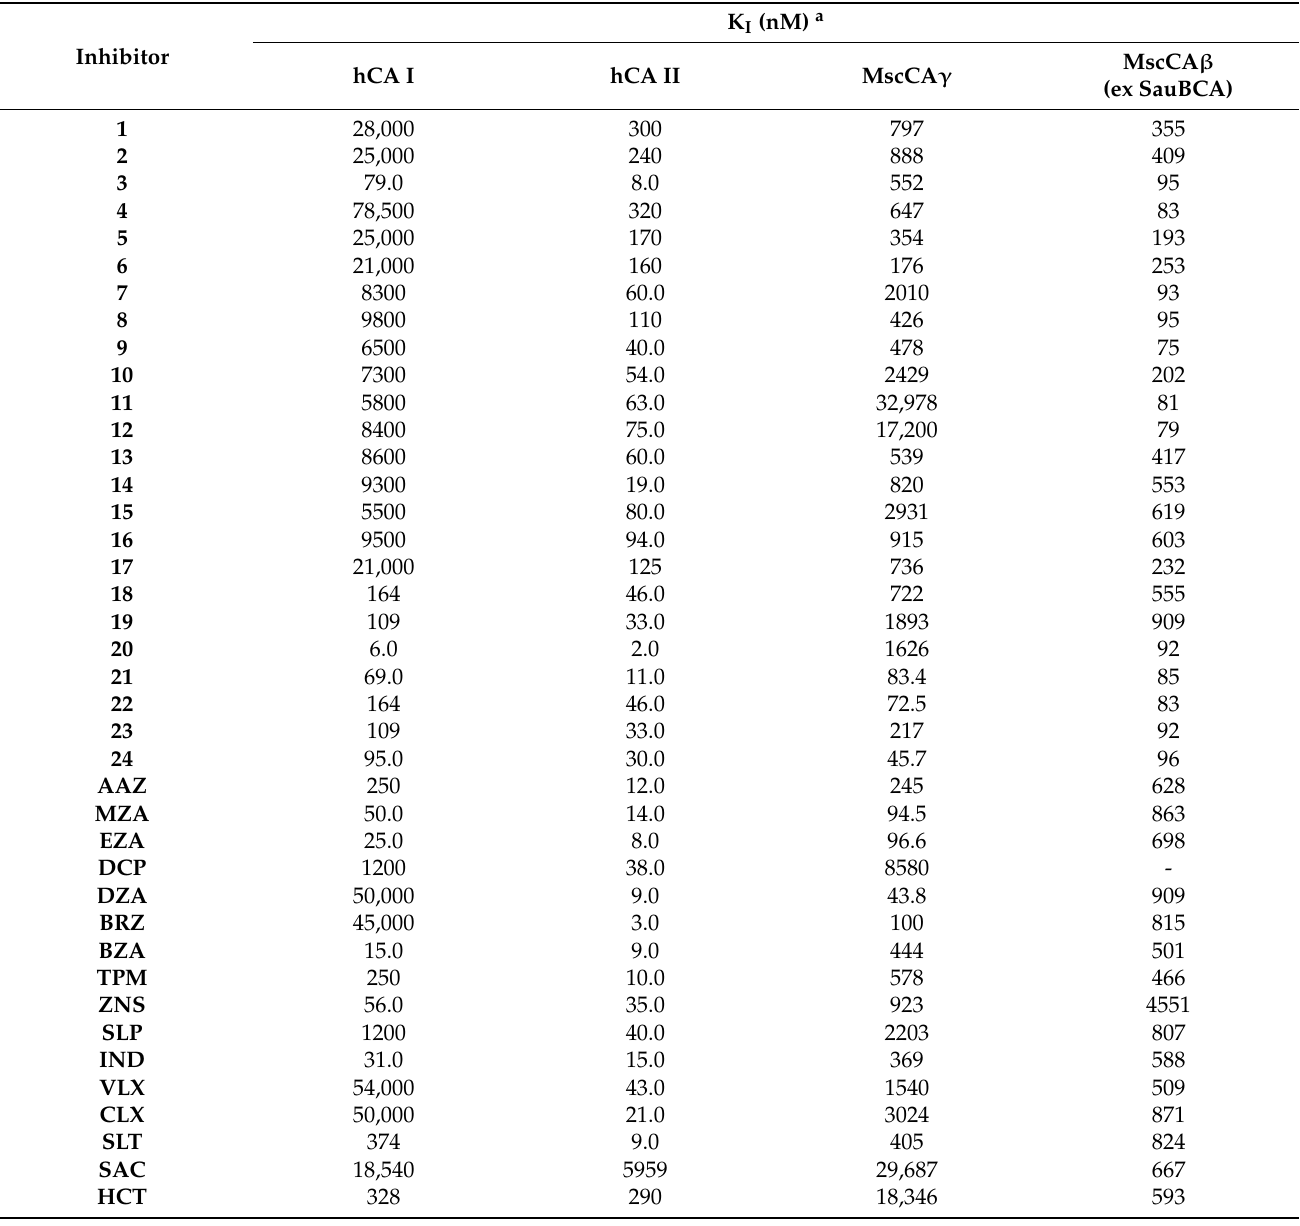
Table 2. Inhibition profile of the β - and γ -CAs from M. sciuri and the two isoforms hCA I and hCA II from Homo sapiens with sulfonamides 1 – 24 and the clinically used drugs AAZ - HCT . A stopped-flow assay was used for the